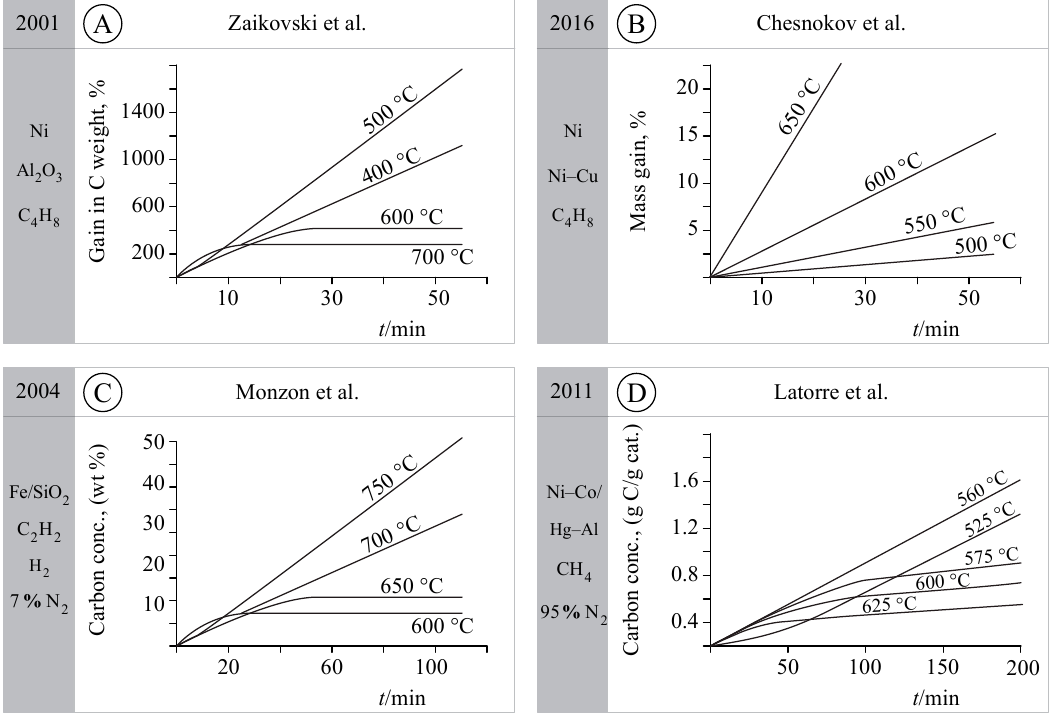
Figure 4. Kinetics observed in carbon formation studies [18–25]. Linearity means steady-state kinetics, i.e., solid-state phases, shape, surface reactions, and fluxes are stable. An Arrhenius plot shows the changes in the rate-determining step or in operating route.